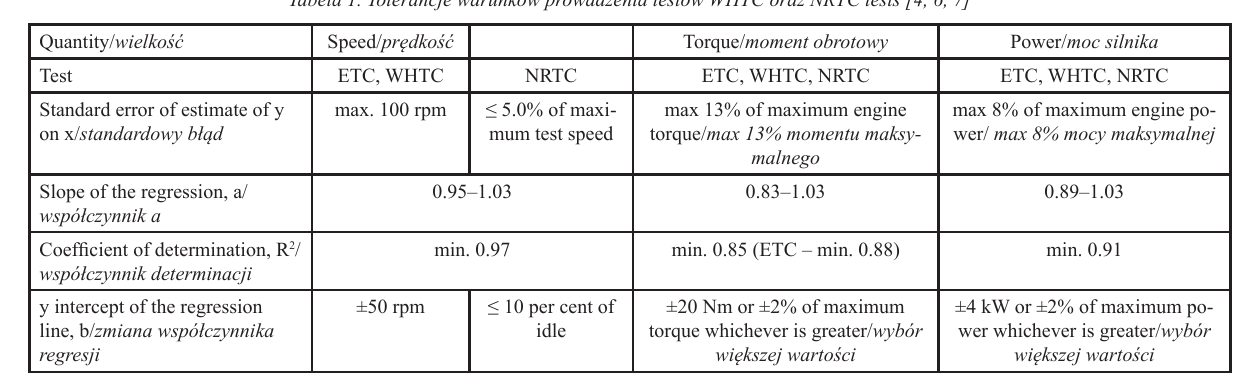
Table 1. Linear regression tolerances in WHTC and NRTC tests [4, 6, 7] Tabela 1. Tolerancje warunków prowadzenia testów WHTC oraz NRTC tests [4, 6,